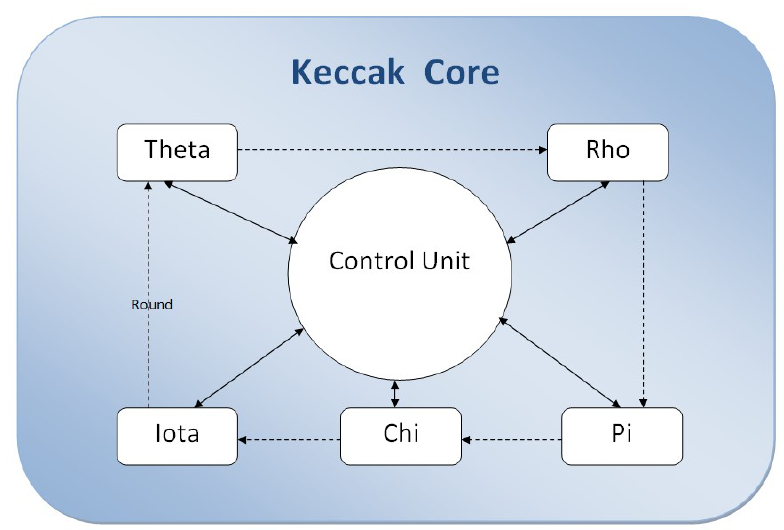
Figure 5. Keccak Core block diagram.